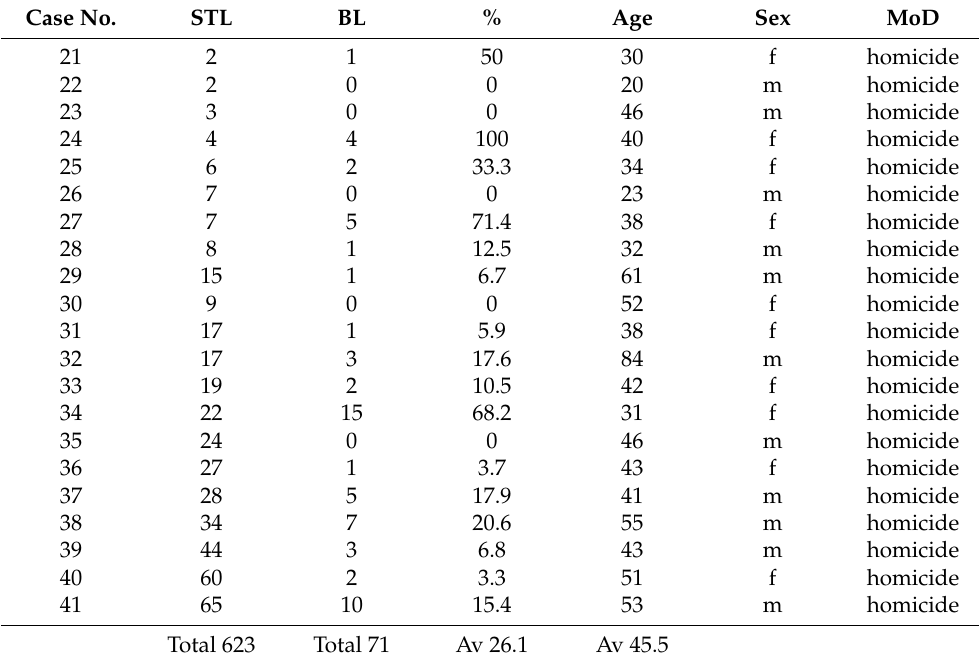
Table 1. Cont. Case